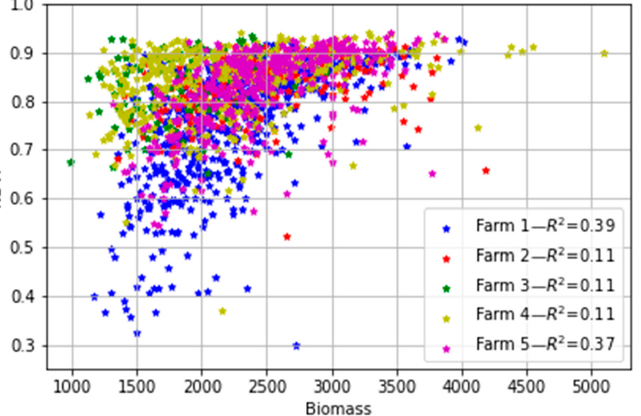
Figure 7. Relationship between the ground-measured biomass (kg DM/ha) and the S2-derived NDVI for the five farms. Each point represents the median NDVI for all pixels in the paddock and the biomass measured on each